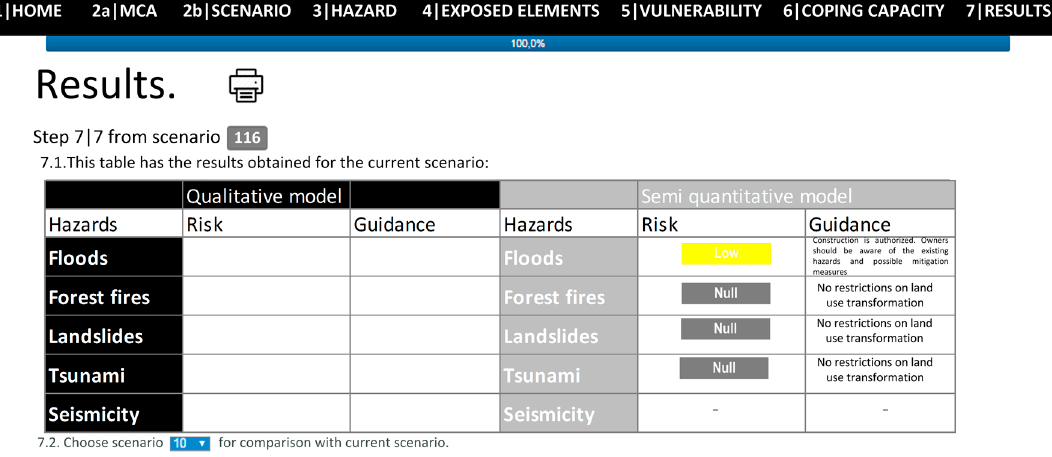
Figure 13. Results for the semi-quantitative risk analysis scenario on a different location.